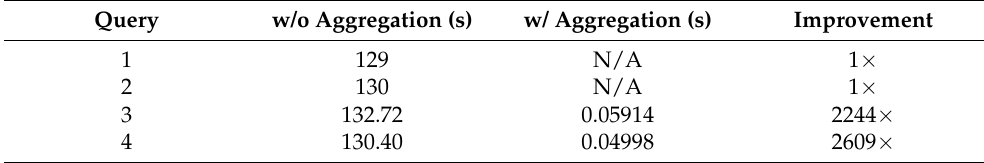
Table 1. Query times with and without aggregation using Fabric